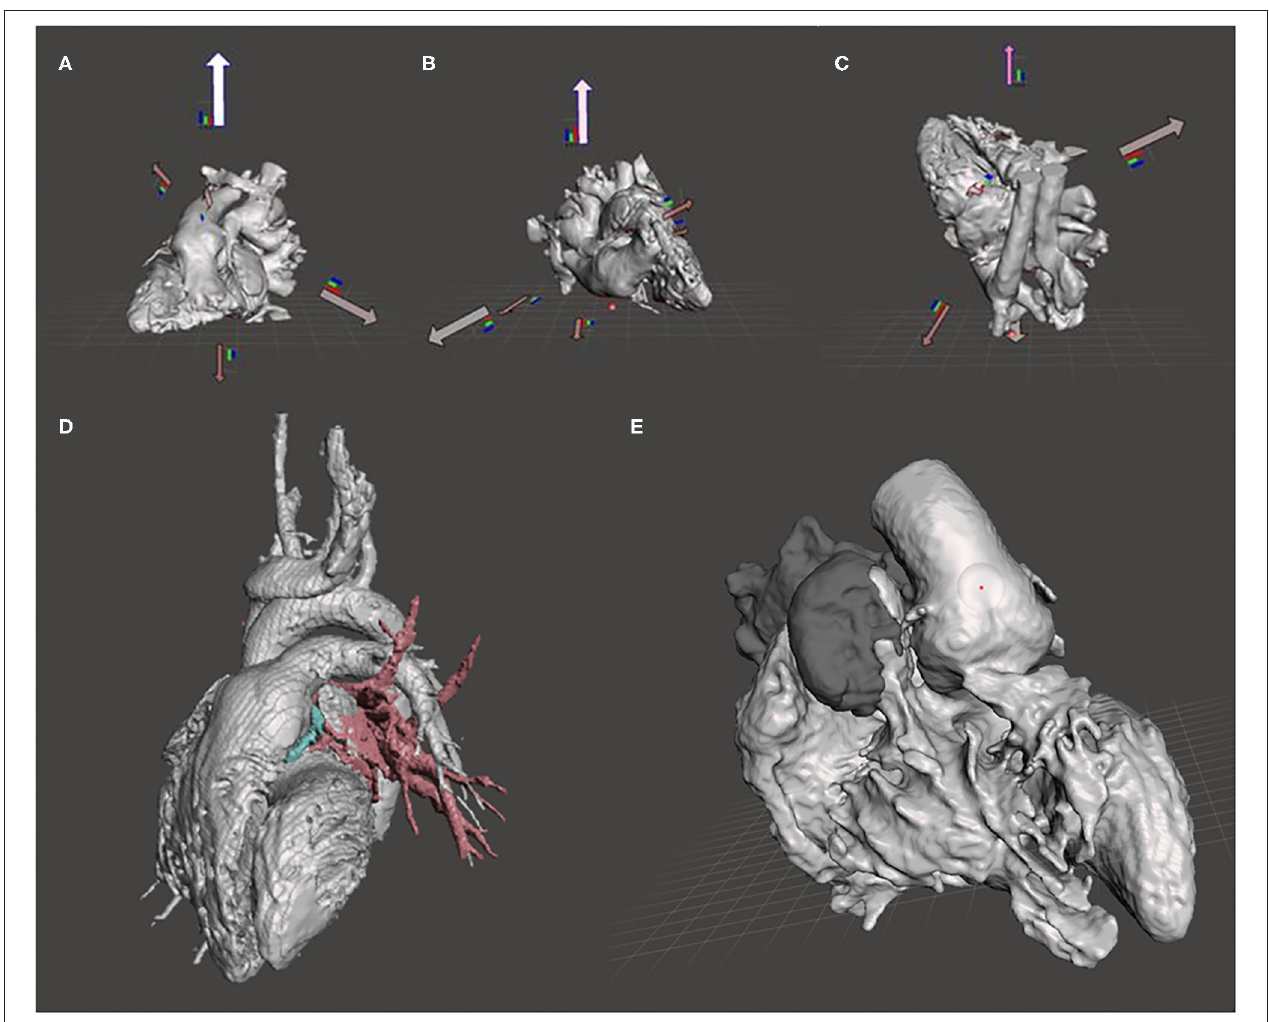
FIGURE 2 | Tools and operations in Meshmixer. (A–C) Optimal printing positions of the heart model calculated by the orientation tool in Meshmixer. (D) Different anatomical structures segmented in ITK Snap. Blood pool in gray, pulmonary veins in red, and coronary in blue. (E) Smooth brush applied on the aorta